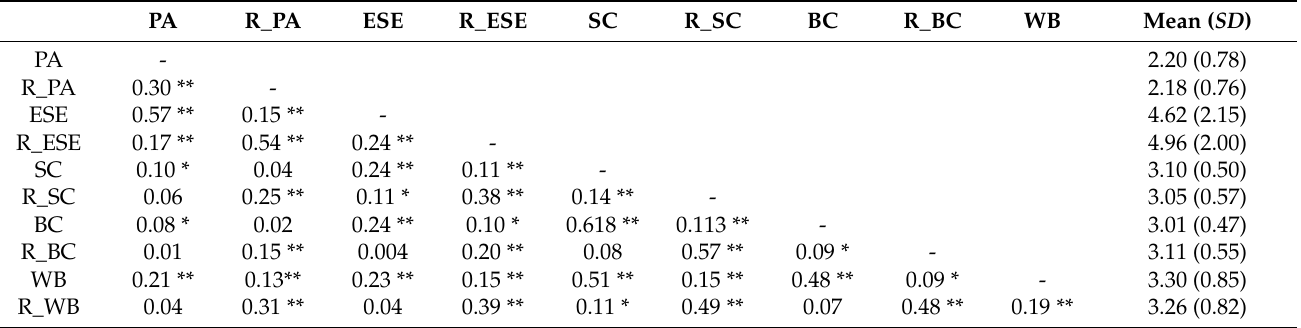
Table 3. Correlation Matrix Among All Variables Between Test and